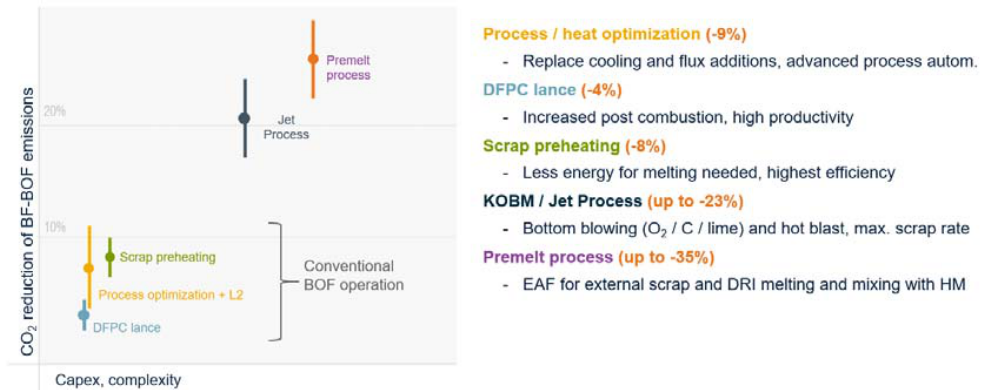
Figure 15. Investment complexity of solution for scrap rate increased in BOF steelmaking compared to its potential to reduce total BF–BOF carbon footprint.